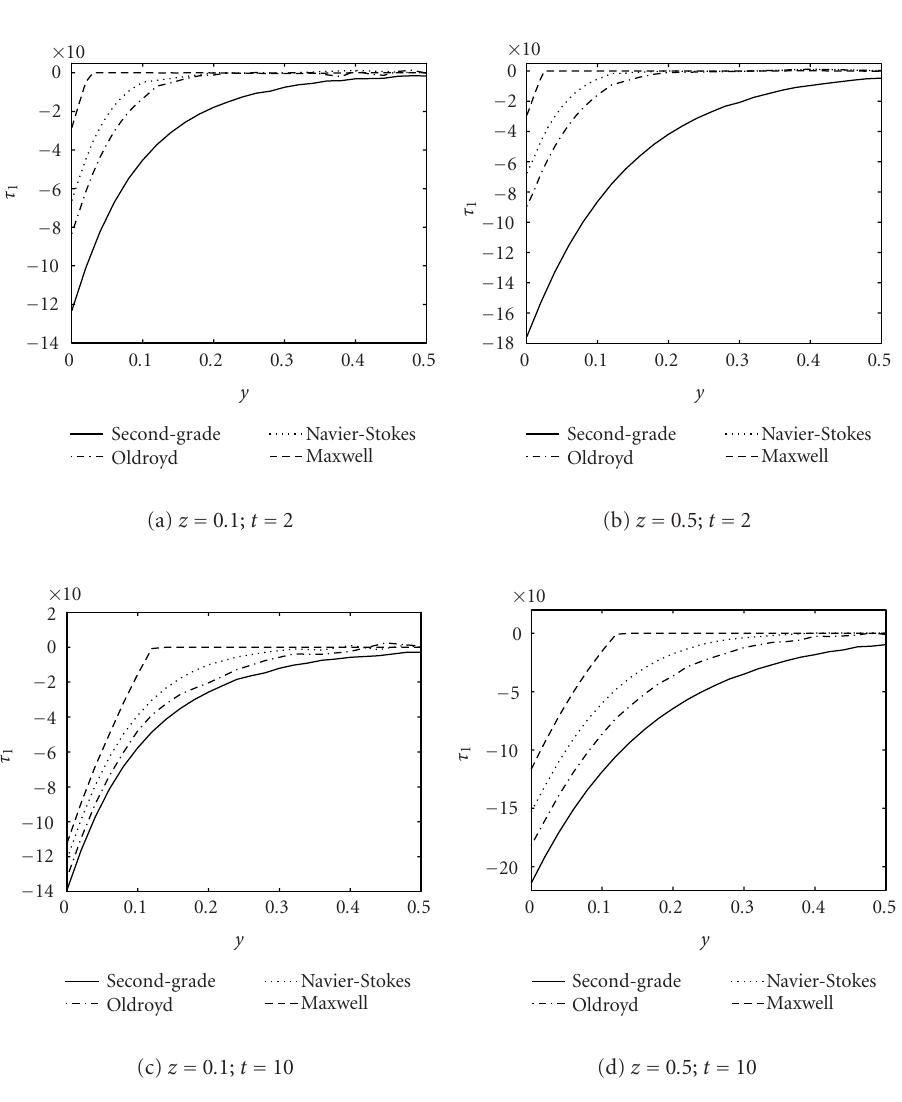
Figure 5.4. Tangential stress τ 1 corresponding to a second grade, Oldroyd, Navier-Stokes, and Maxwell fluid for A = 1 . 0, ν = 0 . 0011746, λ r = 15 and λ = 8, for z = 0 . 1 and z = 0 . 5 cm, and t = 2 and 10 s,